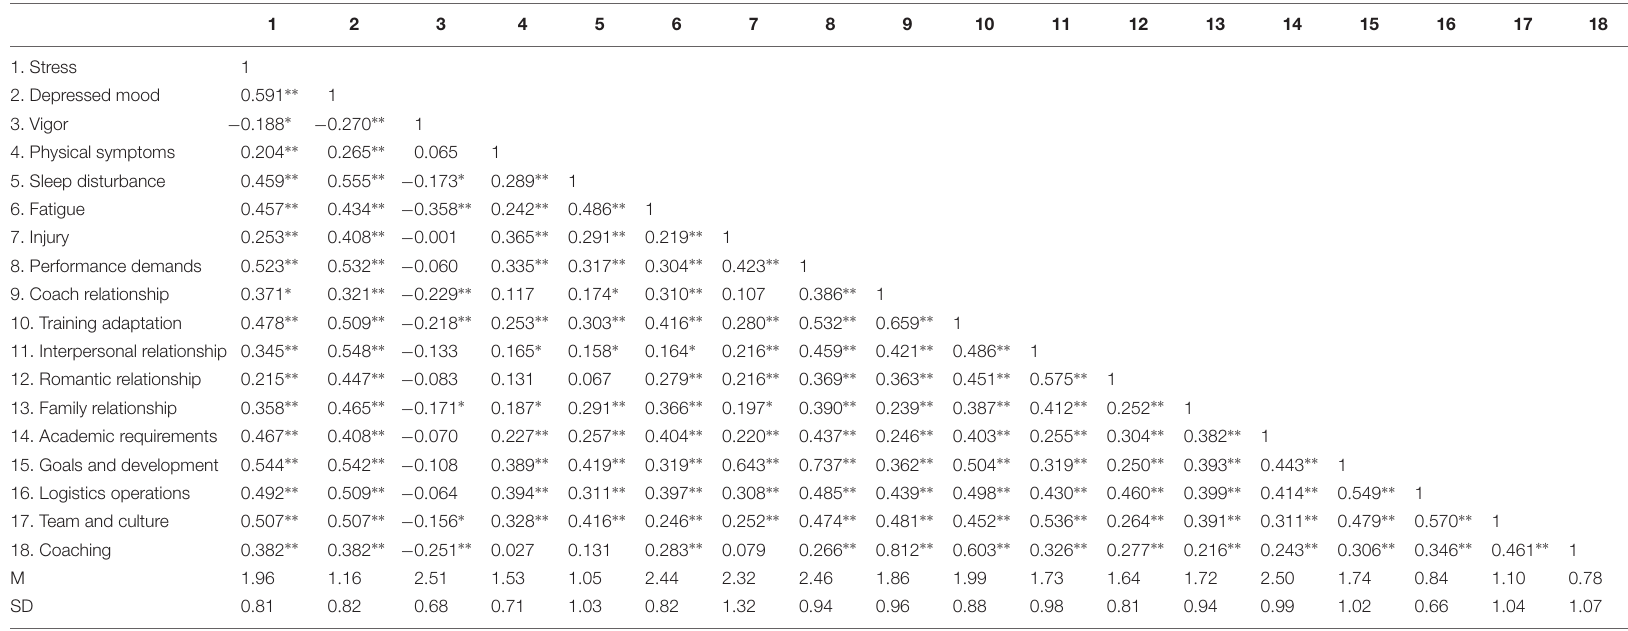
TABLE 1 | Descriptive statistics, correlations for multi-component training distress scale, college student-athlete life stress scale, and organizational stressor indicator for sport performers. 1